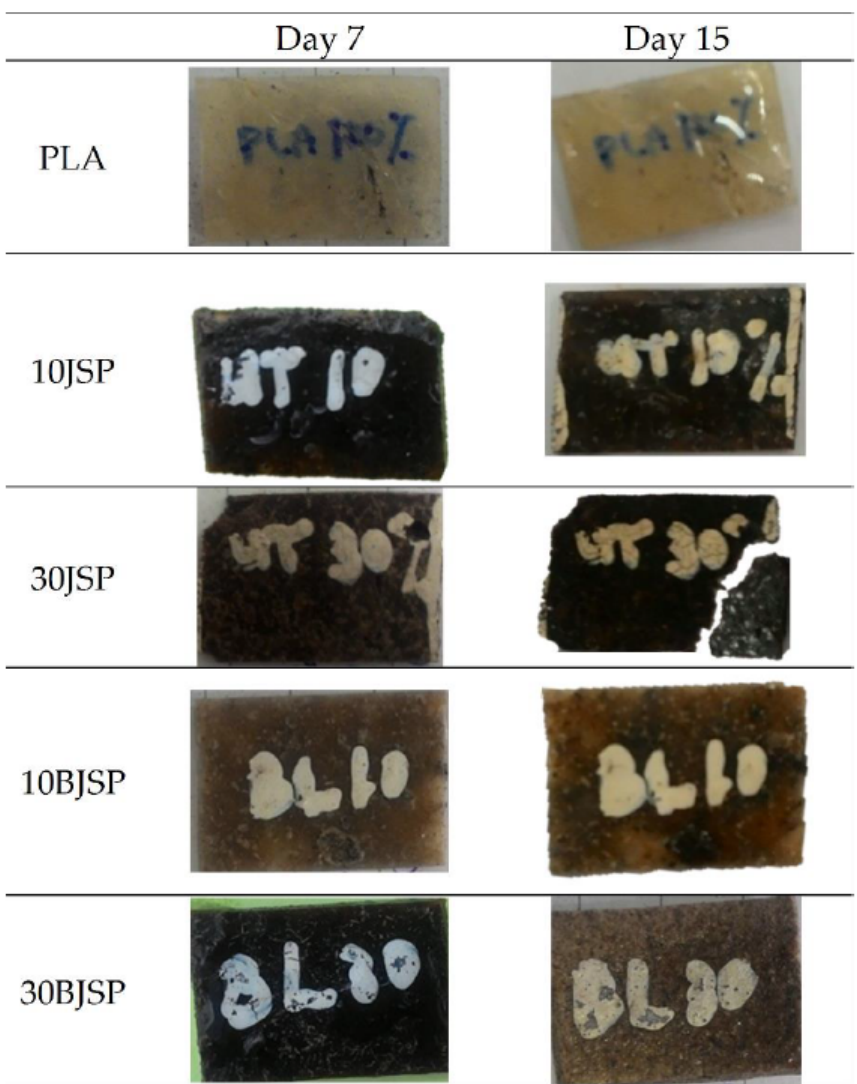
Figure 10. Soil biodecomposed appearance for PLA and its composite.